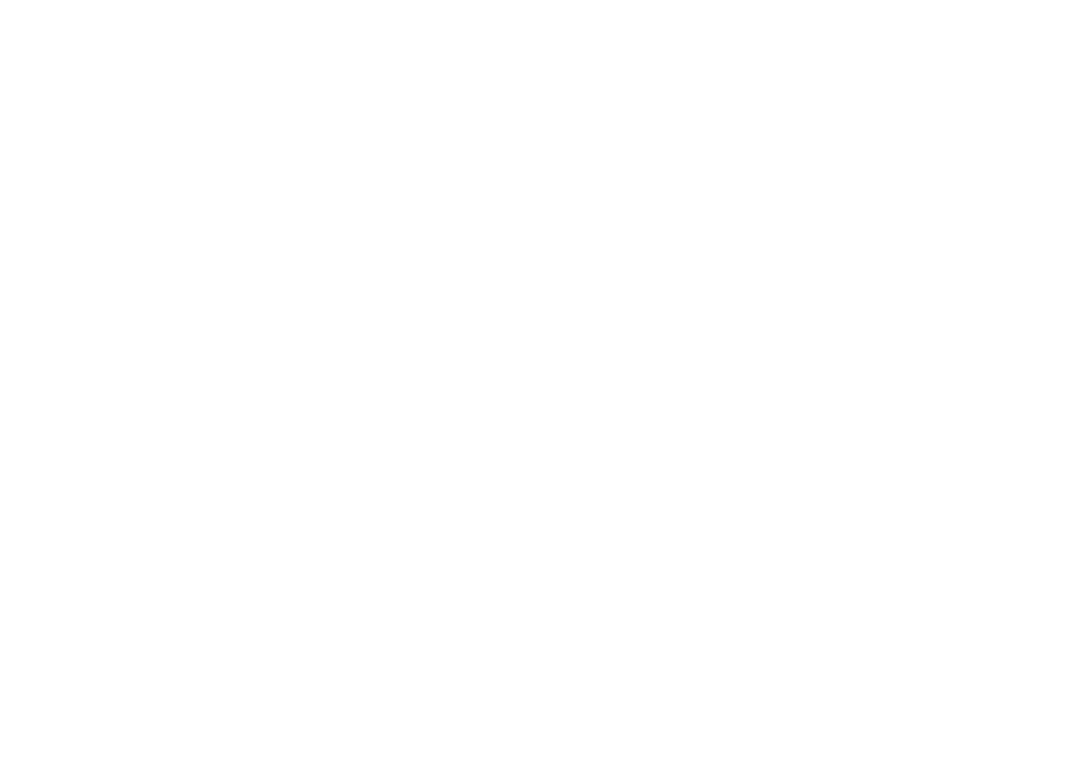
FIGUREA3 | Spatial maps of components in module III for HCs (upper) and SZs (lower). Hubs of this module in each group are labeled. Each column shows one component in axial, sagittal, and coronal views.There are eight common components (in the box) including three occipital components, three cerebellar components, one parahippocampal component, and one temporal component. HCs have five additional components including two frontal